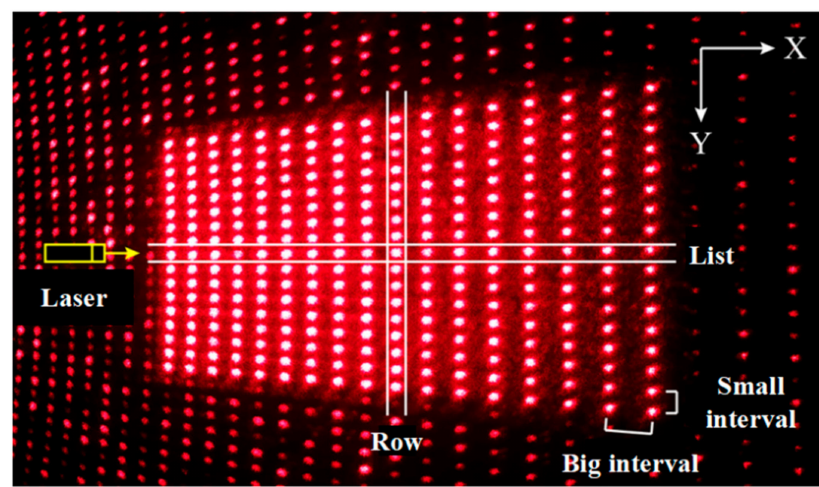
Figure 3. The trapezoid dot-matrix points projected by oblique laser generator.